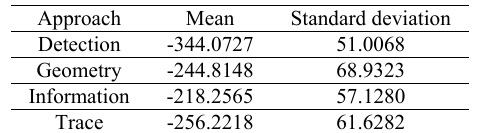
Table 1. Mean and standard deviation of similarity values calculated from homogeneous area